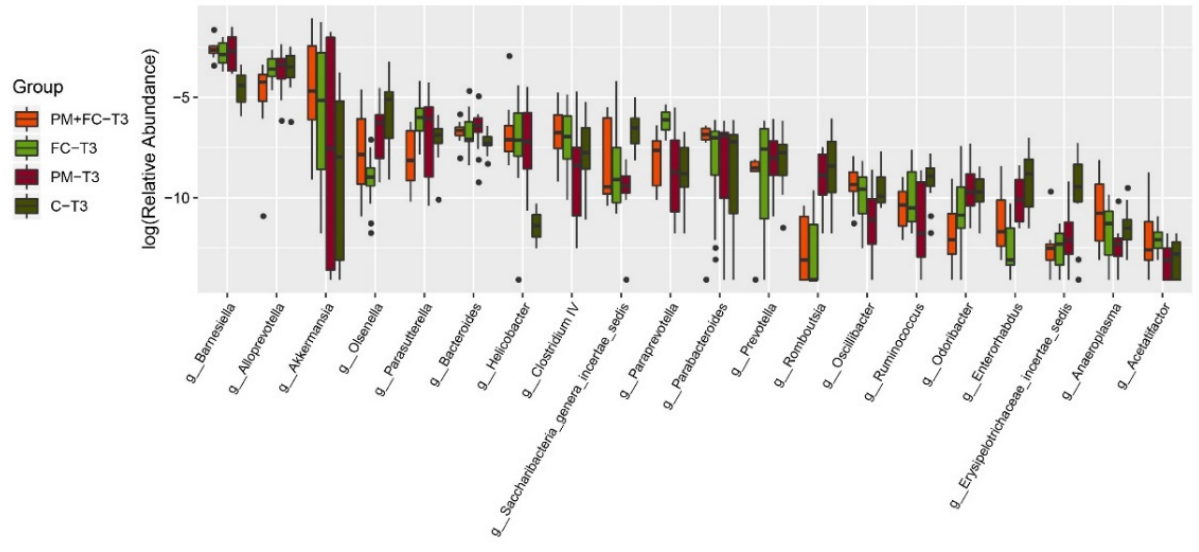
Figure 11. Abundance of significantly different bacteria in gut microbiota among four groups at T3.